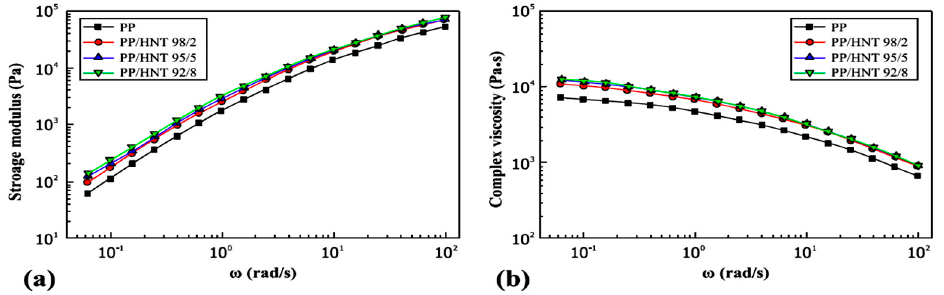
Figure 11. ( a ) Storage modulus ( G' ) and ( b ) complex viscosity ( η * ) as a function of frequency ( ω ) for pure PP and as-extruded PP/HNTs nanocomposites with different weight ratios [85].